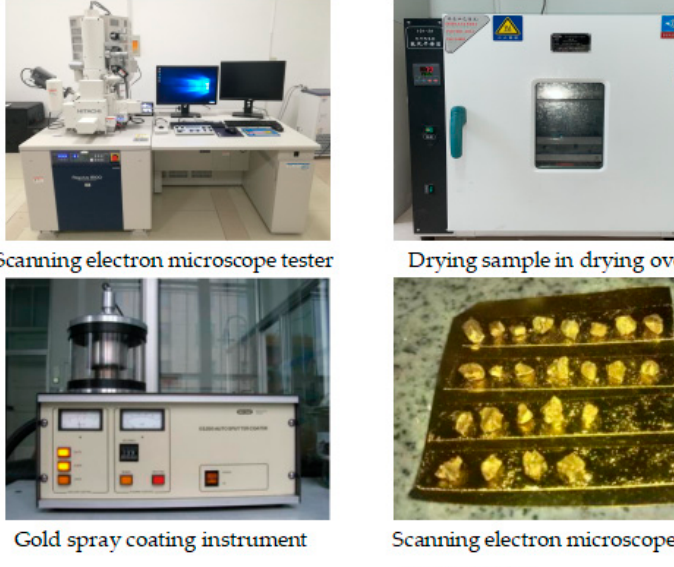
Figure 3. Measurement of SEM. Table 3. The test device specifications and standards corresponding to different experiments.